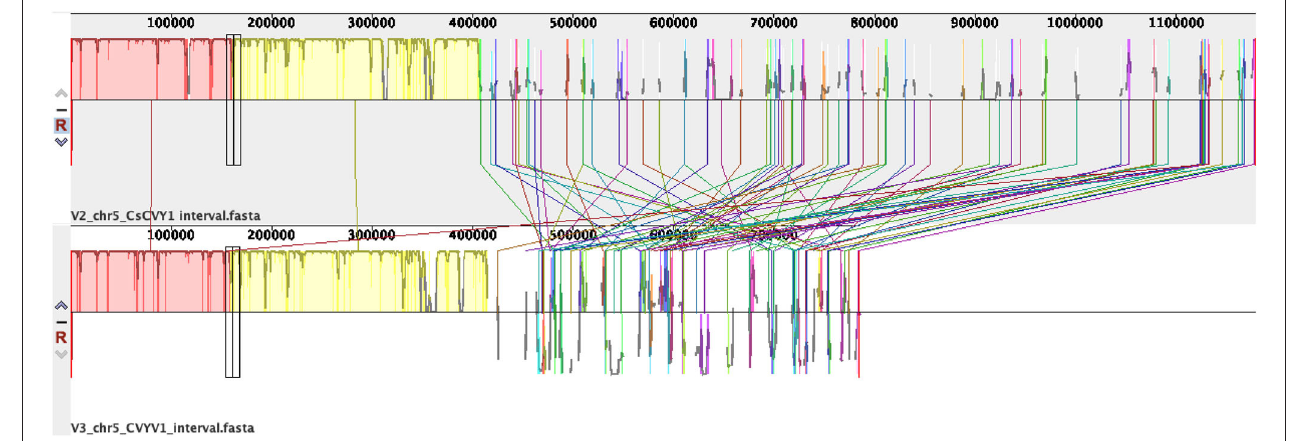
FIGURE 2 | Pairwise sequence alignment of CsCvy-1 interval in reference genomes version two and three (GCA_000004075.2 and GCA_000004075.3). Sequences were aligned using Progressive Mauve (Darling et al., 2004).